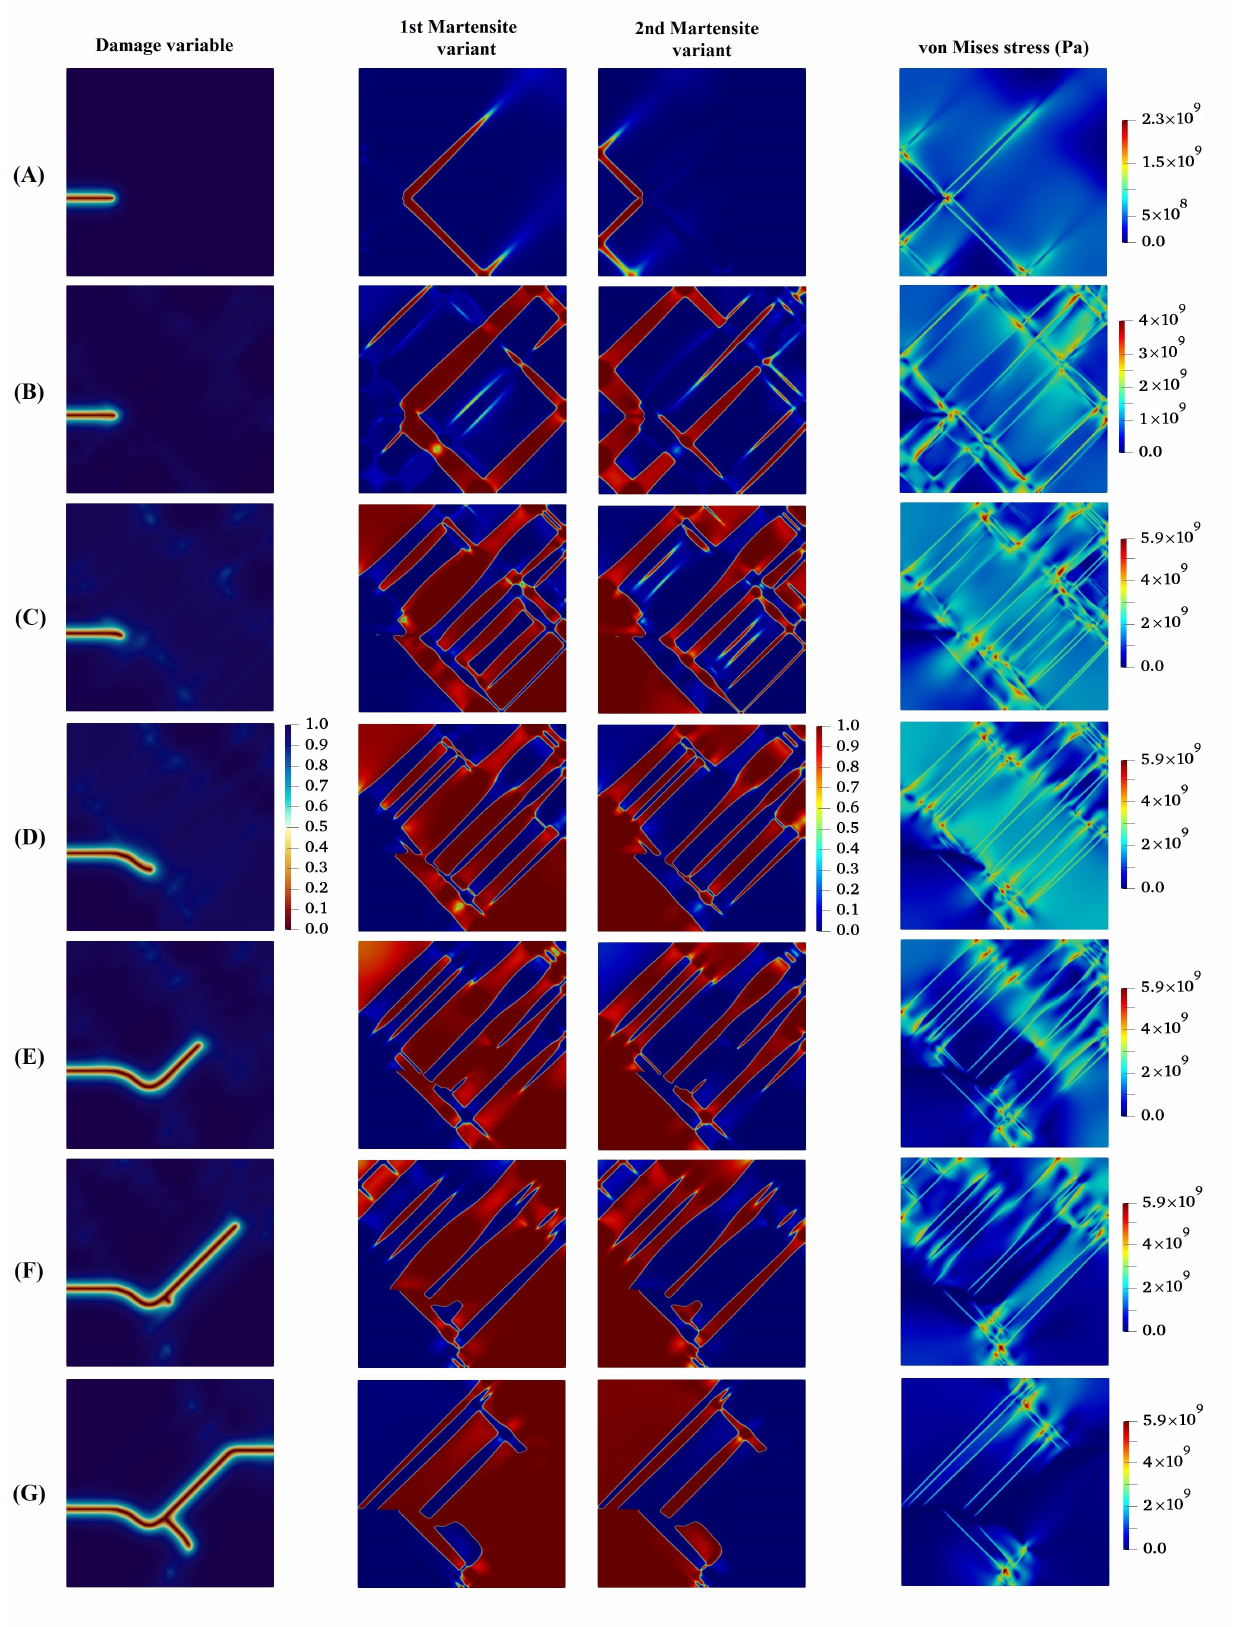
Figure 8. Evolution of damage variable, two martensite variants, and von Mises stress in the austenitic microstructure under Mode I loading with crystal lattice orientation of 45°